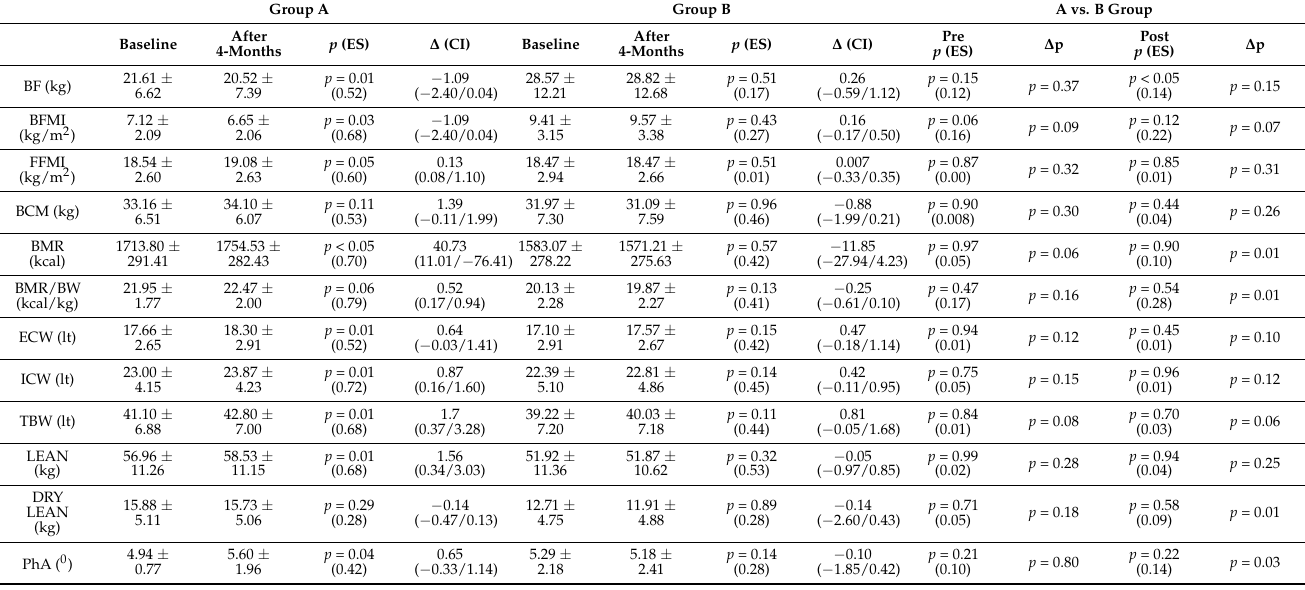
Table 3. Bioelectrical impedance analysis of the KT recipients at baseline and the end of the study. GroupB Avs.